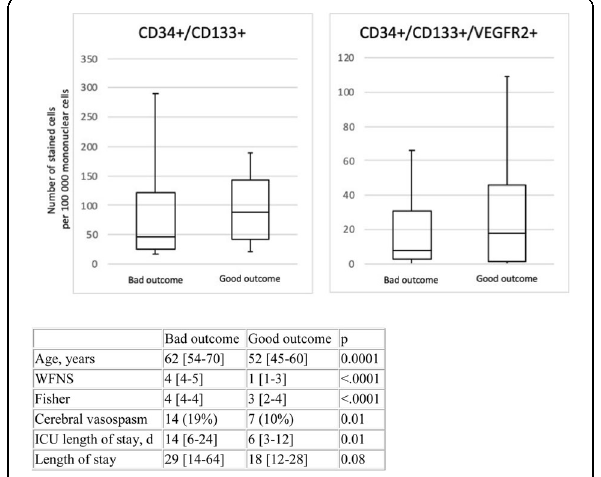
Fig. 2 (abstract 000832). mRS outcome vs age